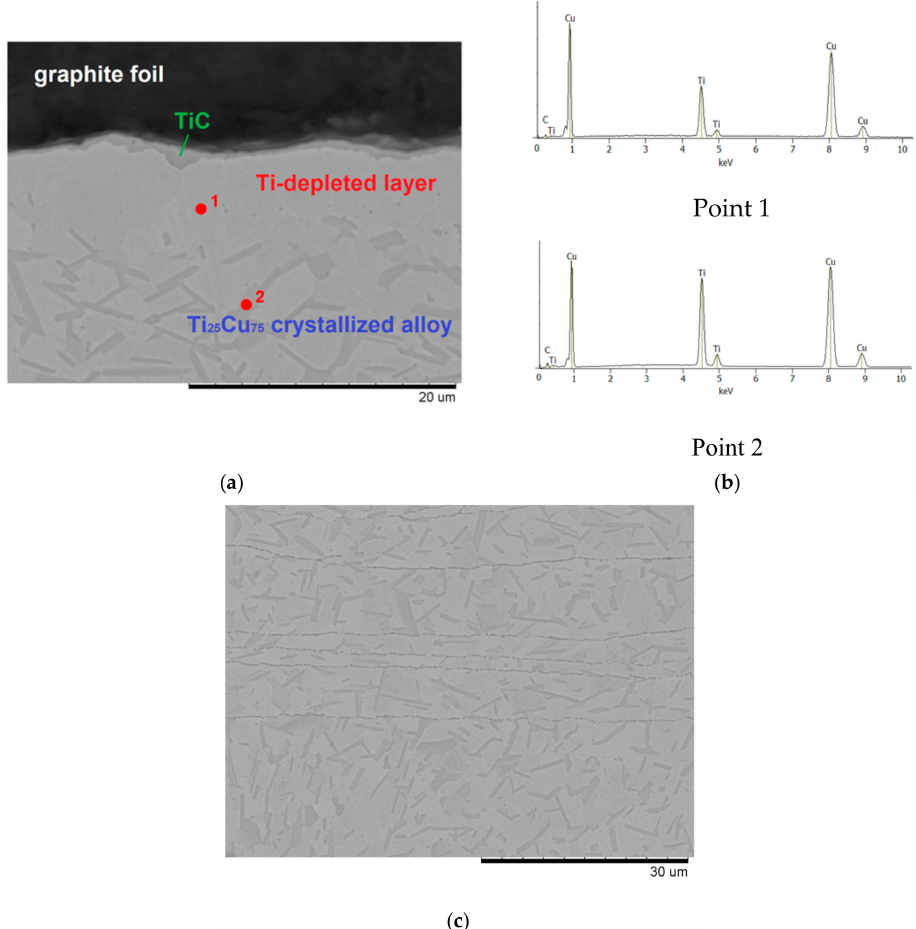
Figure 7. Cross-section of the graphite foil / Ti 25 Cu 75 ribbon specimen processed by SPS at 800 ◦ C for 10 min: graphite / alloy interface ( a ); results of the EDS analysis ( b ); center of the specimen—microstructure of the crystallized alloy ( c ). The images were taken in the back-scattered electron